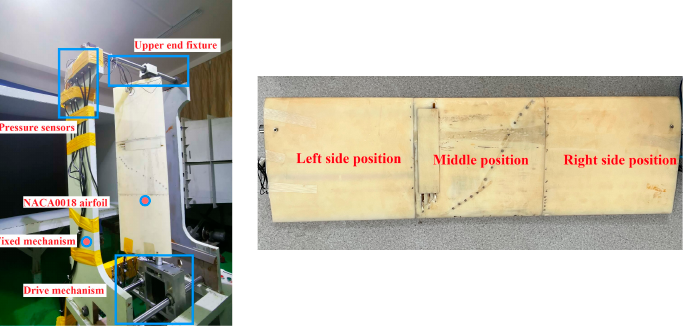
Figure 2. Schematic diagram of the experimental platform and experimental mode.